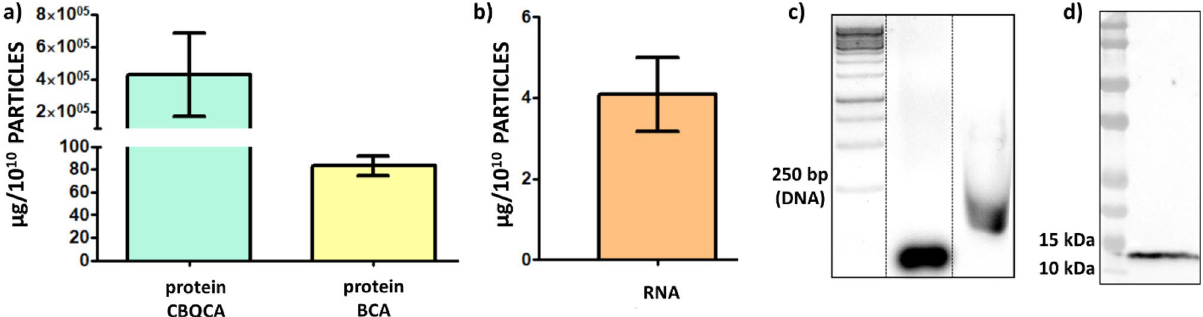
Figure 2. Slug EXs content analysis. ( a ) Comparison of the EXs protein concentrations provided by BCA and CBQCA quantification assays. ( b ) RNA content of the slug EXs. ( c ) RNA isolated from the slug EXs (lane 3) compared to loading control siRNA (21mer duplex with dTdT overhang, Sigma-Aldrich; lane 2) and to the DNA ladder (lowest band = 250 bp; lane 1). ( d ) Western blot analysis of slug EXs lysate using a Galectin-1/ LGALS1 primary antibody against human galectin-1 protein (for the uncropped western blots and gels see supplemental data).